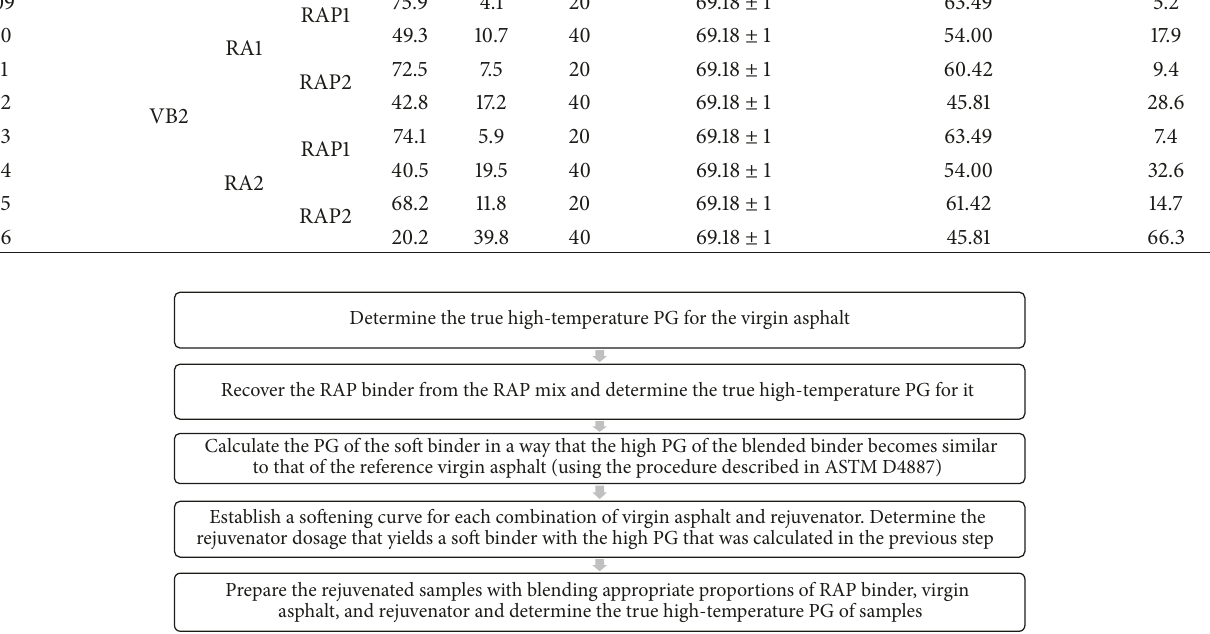
Figure 3: The flowchart for the sample preparation